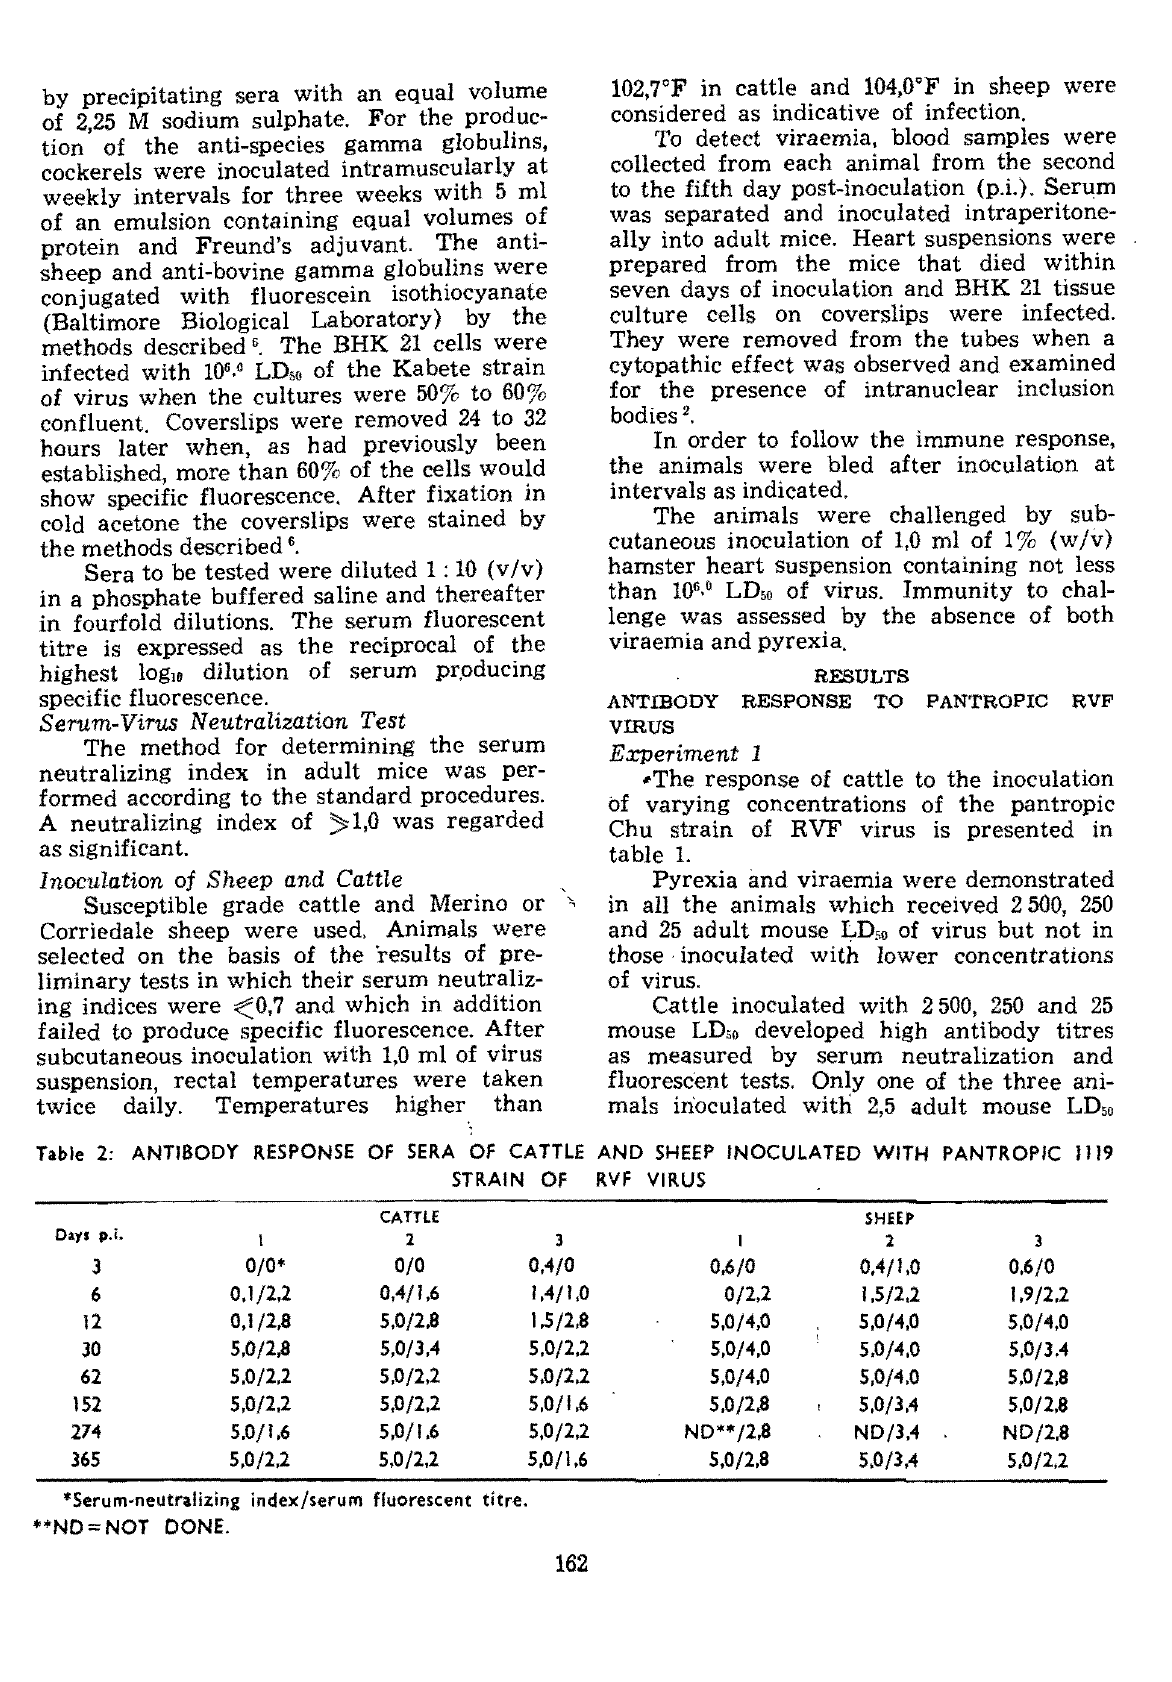
Table 2: ANTIBODY RESPONSE OF SERA OF CATTLE AND SHEEP INOCULATED WITH PANTROPIC 1119 STRAIN OF RVF VIRUS CATTLE SHUI> Days poi.